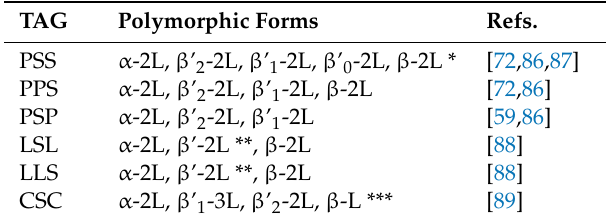
Table 2. Polymorphic forms of main mixed-acid tri-saturated